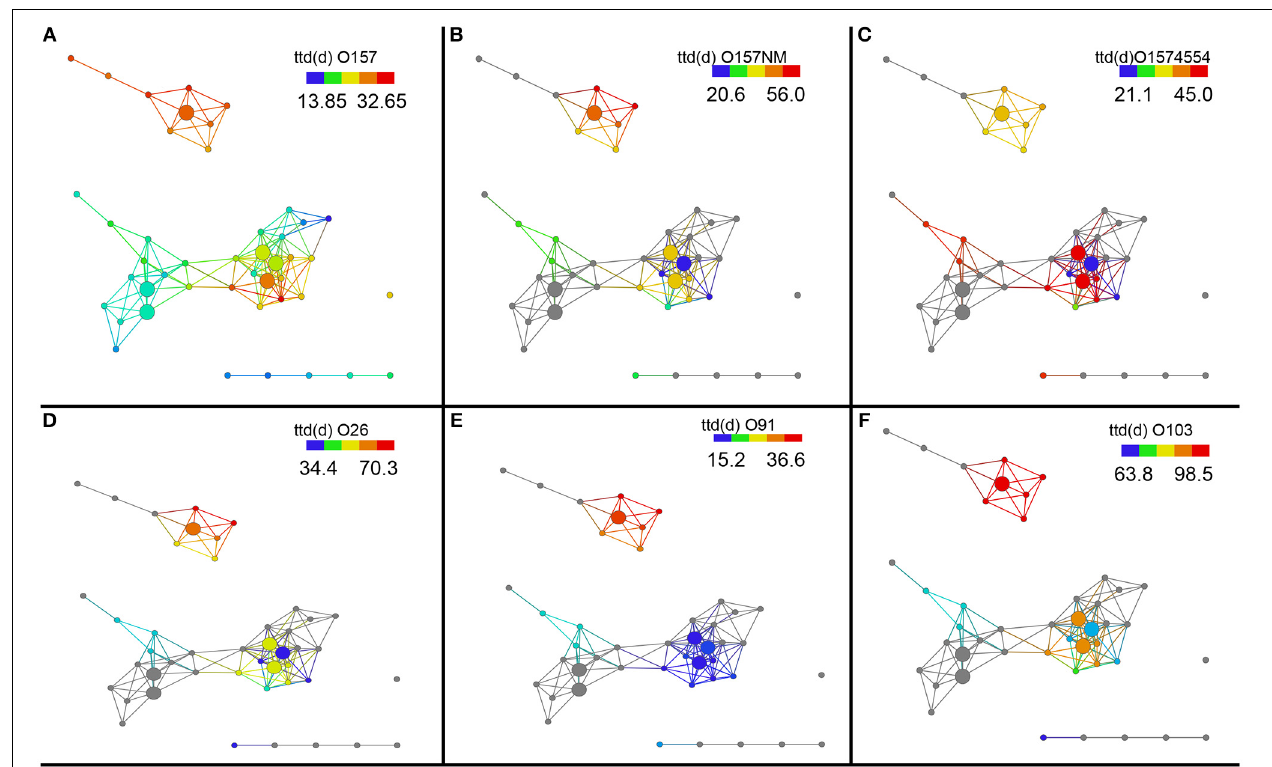
FIGURE 3 | Topological network data analysis of survival of E. coli O157:H7 and non-O157:H7 across the sub-networks identified in Figure 1A. Survival of E. coli O157:H7 EDL933, E. coli O157:NM, and E. coli O157 strain 4554 (stx-) and shown in (A–C) . Survival of non-O157 strains,